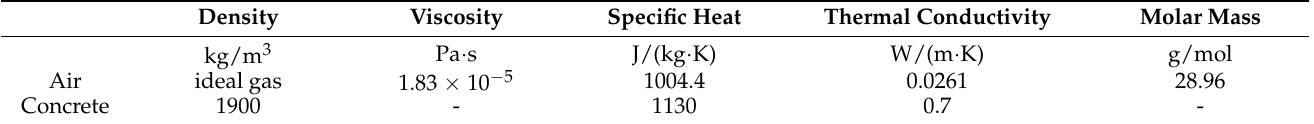
Table 2. Thermal properties of used materials.